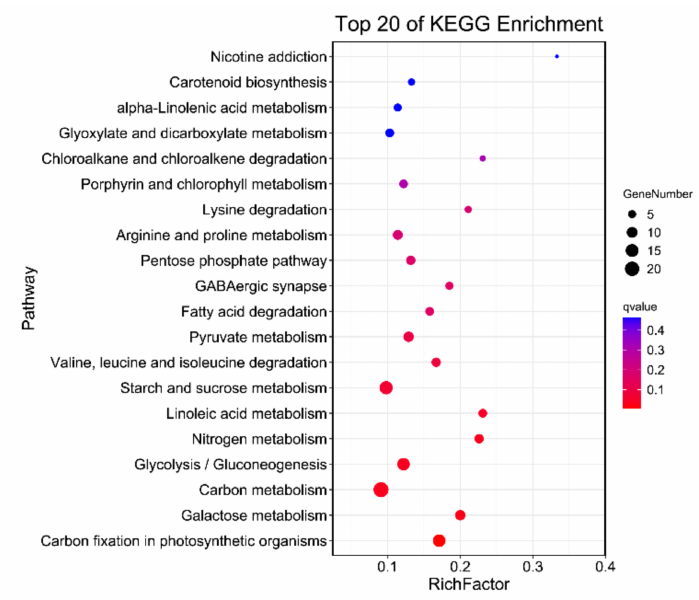
Figure 3. The top 20 statistics of KEGG pathway enrichment for the DEGs. The Rich factor is the ratio of DEGs in this pathway term to all the number of genes annotated in this pathway